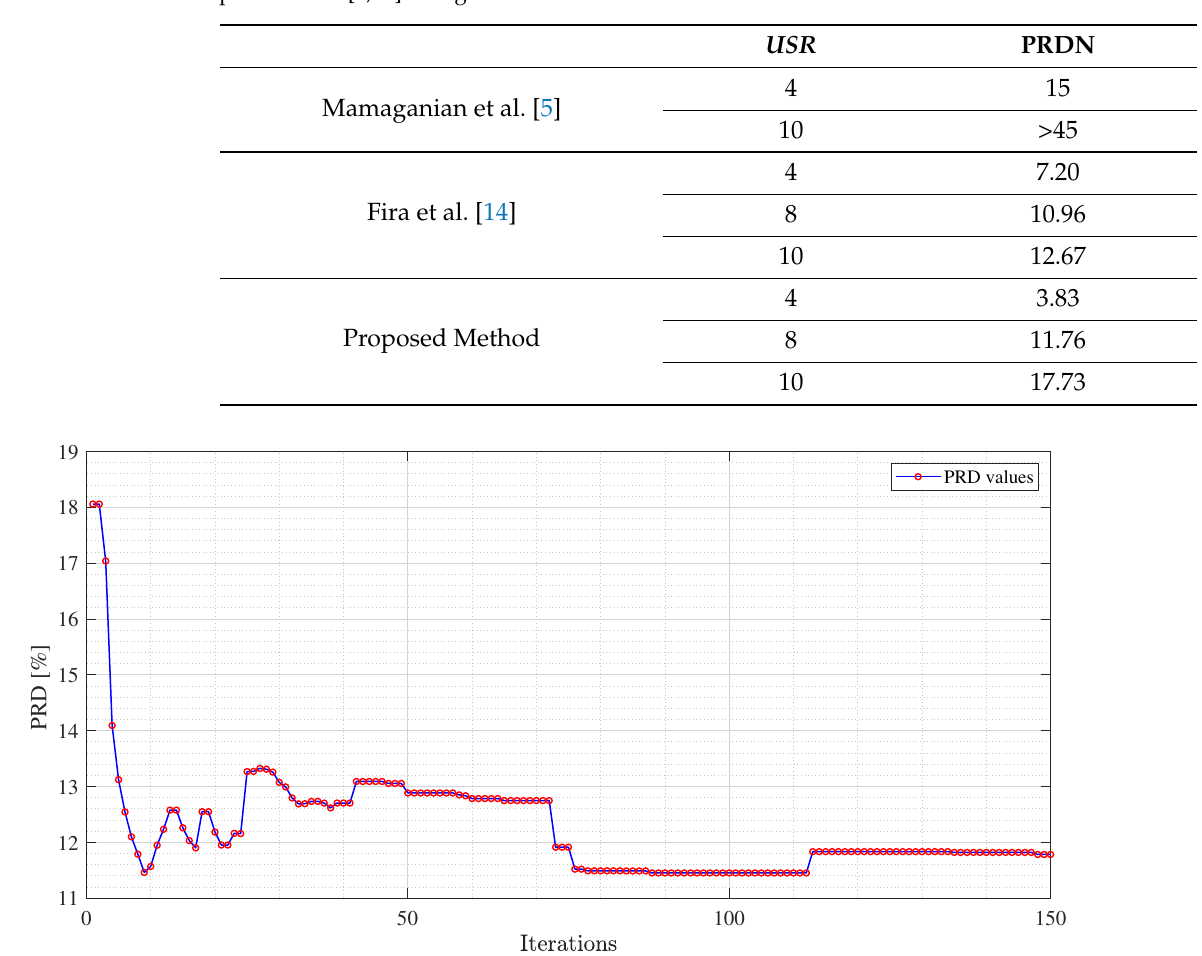
Table 13. Performance comparison between the proposed method and the reconstruction techniques presented in [5,14] on signal number 117.